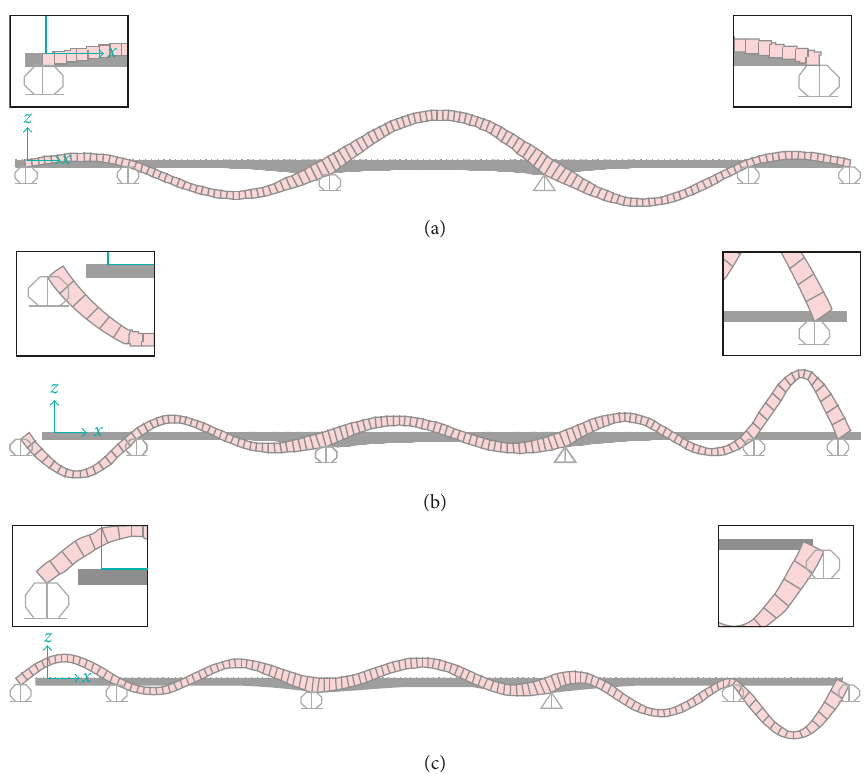
Figure 6: Longitudinal mode shapes from FEM analysis: (a) mode 1 (1.58Hz; modal participating mass ratio 0.1), (b) mode 2 (4.35 Hz; modal participating mass ratio 0.17), and (c) mode 3 (5.06 Hz; modal participating mass ratio